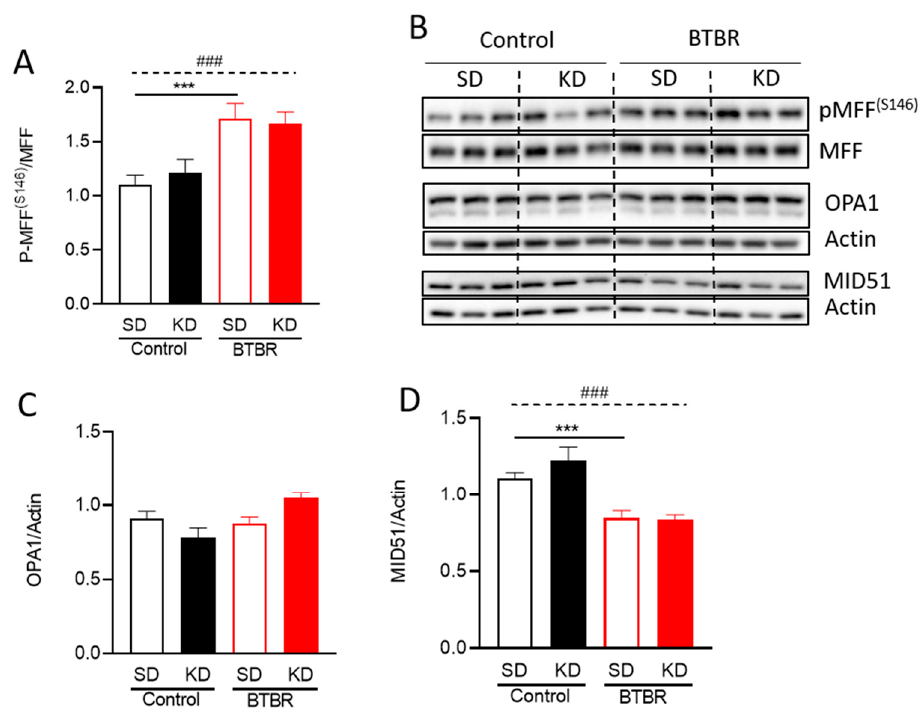
Figure 6. Changes in mitochondrial dynamic proteins due to KD. Densitometry analysis of ( A ) P-MFF S146 , ( C ) OPA1, and ( D ) MID51. ( B ) Representative blots for the densitometry analysis in (A,C,D). Data are shown as mean ± SEM, n = 6 per group. Data were analyzed by two-way ANOVA. The significant effects (main effects from two-way ANOVA) are presented as ### p < 0.001. Further, the significant differences between groups revealed by the post-hoc analysis are presented as *** p < 0.001.